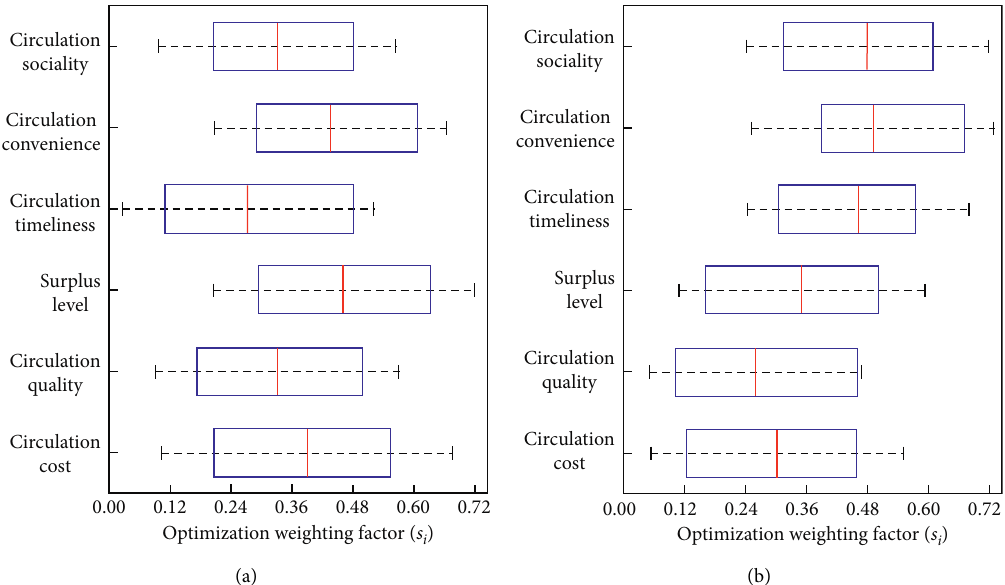
Figure 7: Optimization weighting factors ( s i ) of influential factors in IoT-based e-commerce supply chain with horizontal (a) and vertical (b) integration